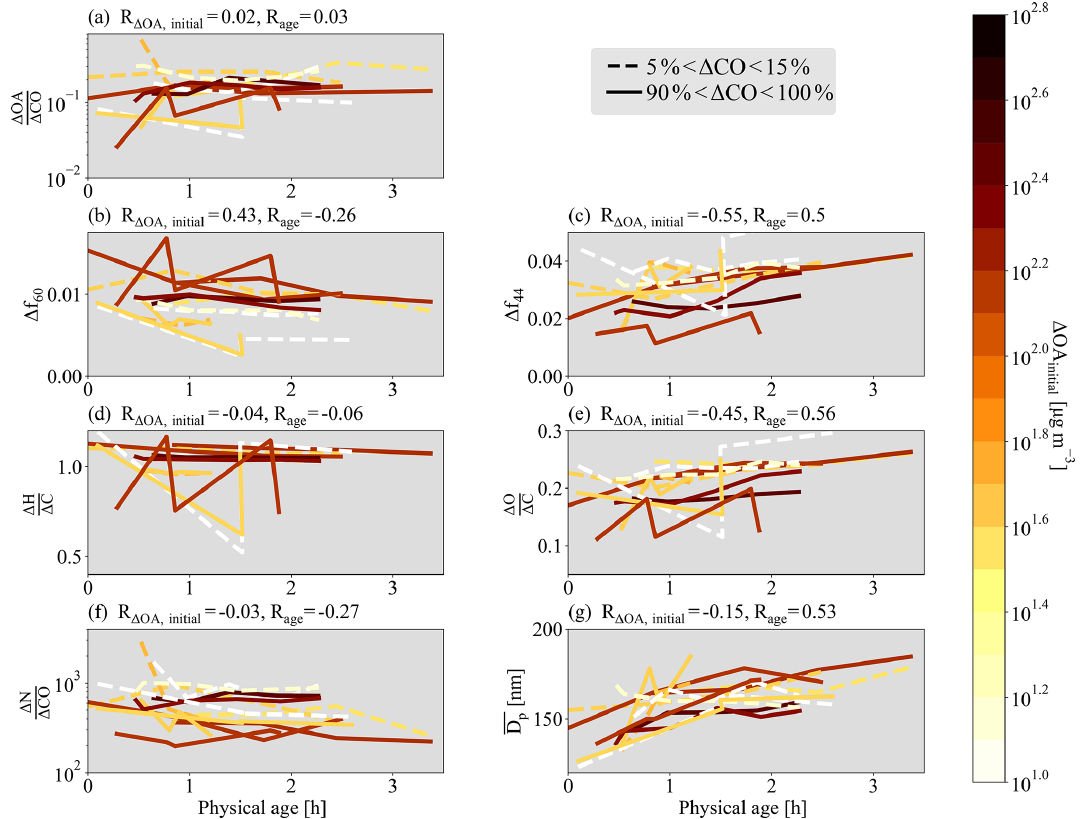
Figure 2. Various normalized parameters as a function of physical age for the seven sets of pseudo-Lagrangian transects. Separate lines are shown for the edges (lowest 5%–15% of (cid:49) CO; dashed lines) and cores (highest 90%–100% of (cid:49) CO; solid lines). (a) (cid:49) OA /(cid:49) CO, (b) (cid:49)f 60 , (c) (cid:49)f 44 , (d) (cid:49) H /(cid:49) C, (e) (cid:49) O /(cid:49) C, (f) (cid:49) N /(cid:49) CO, and (g) D p between 40–262nm against physical age for all flights, colored by (cid:49) OA initial . Some flights have missing data. Also provided is the Spearman correlation coefficient, R , between each variable and (cid:49) OA initial and physical age for each variable. Note that panels (a) and (f) have a log y